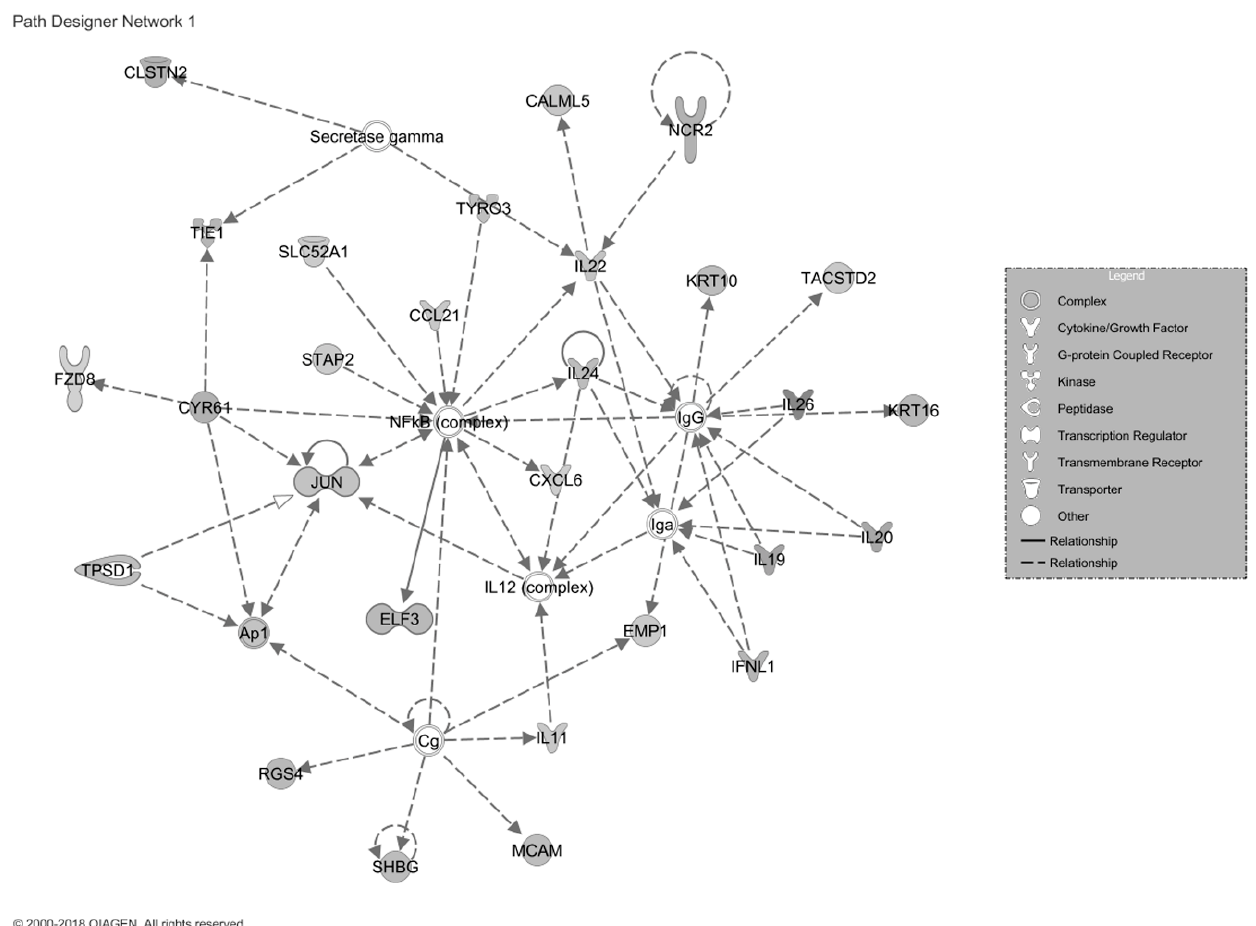
Figure 3. Representation of the dermatological signaling pathway. The 28 filled icons represent genes with increased expression, demonstrating strong activation of the pathway proposed as the main cause of dermatological ADRs.